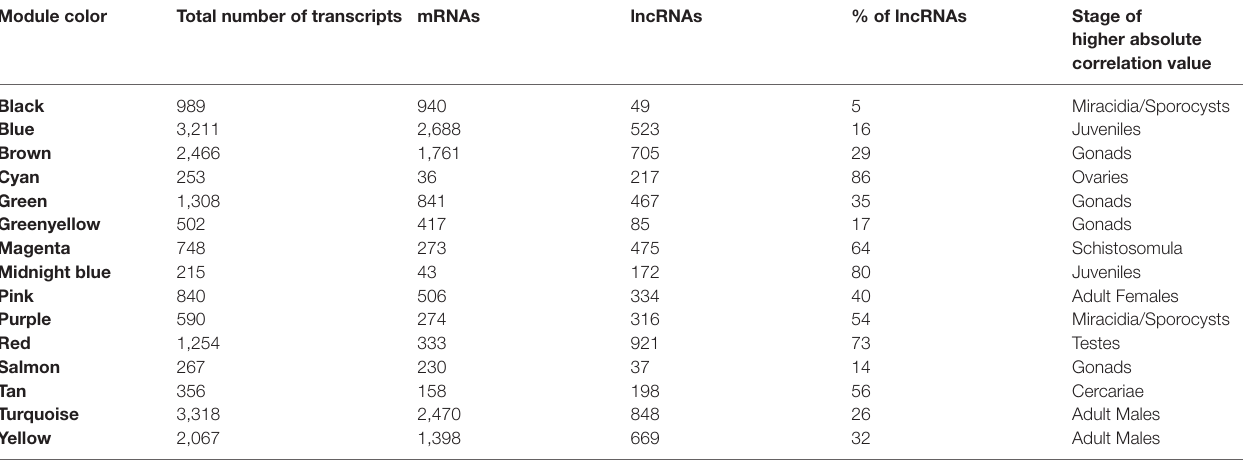
TABLE 2 | Number of transcripts per module and percentage of lncRNAs in each module. Module